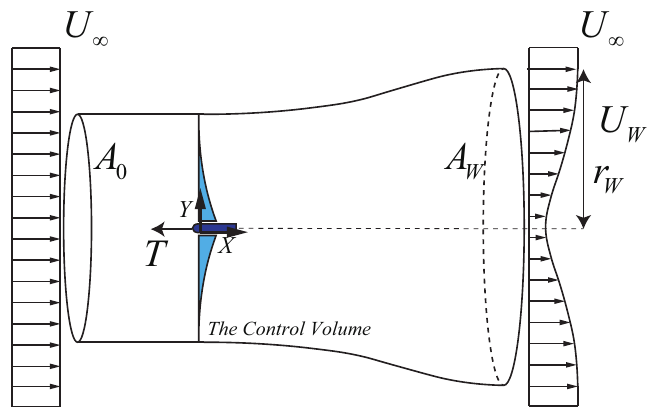
Figure 2. Schematic of the control volume around the wind